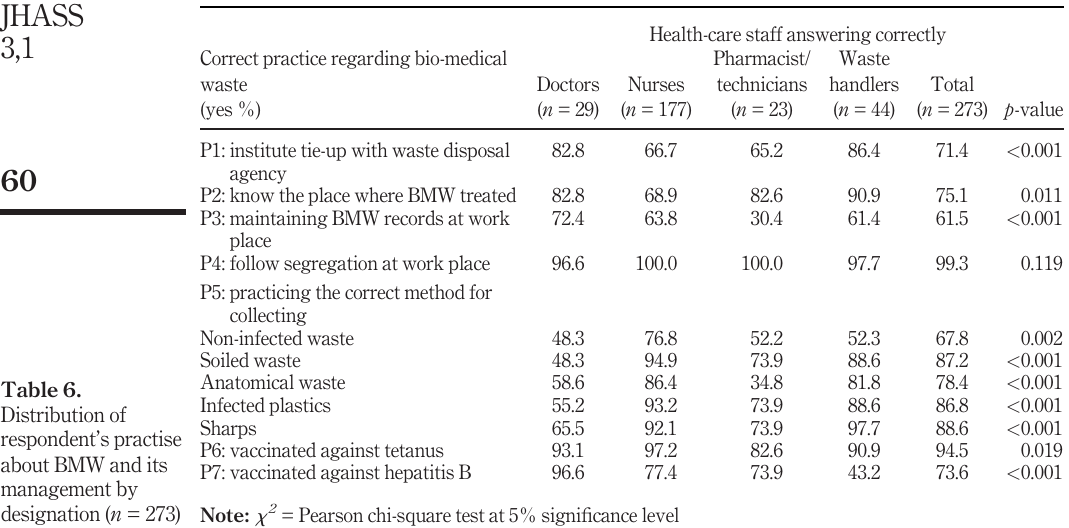
Table 6. Distribution of respondent ’ s